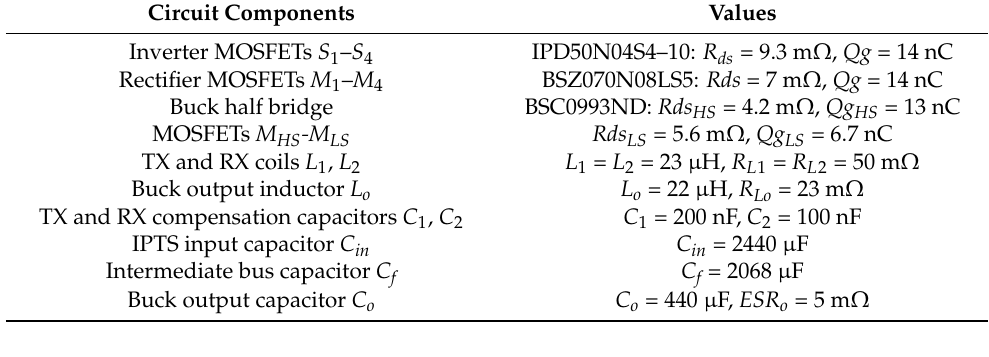
Table 7. PR-IPTS components.